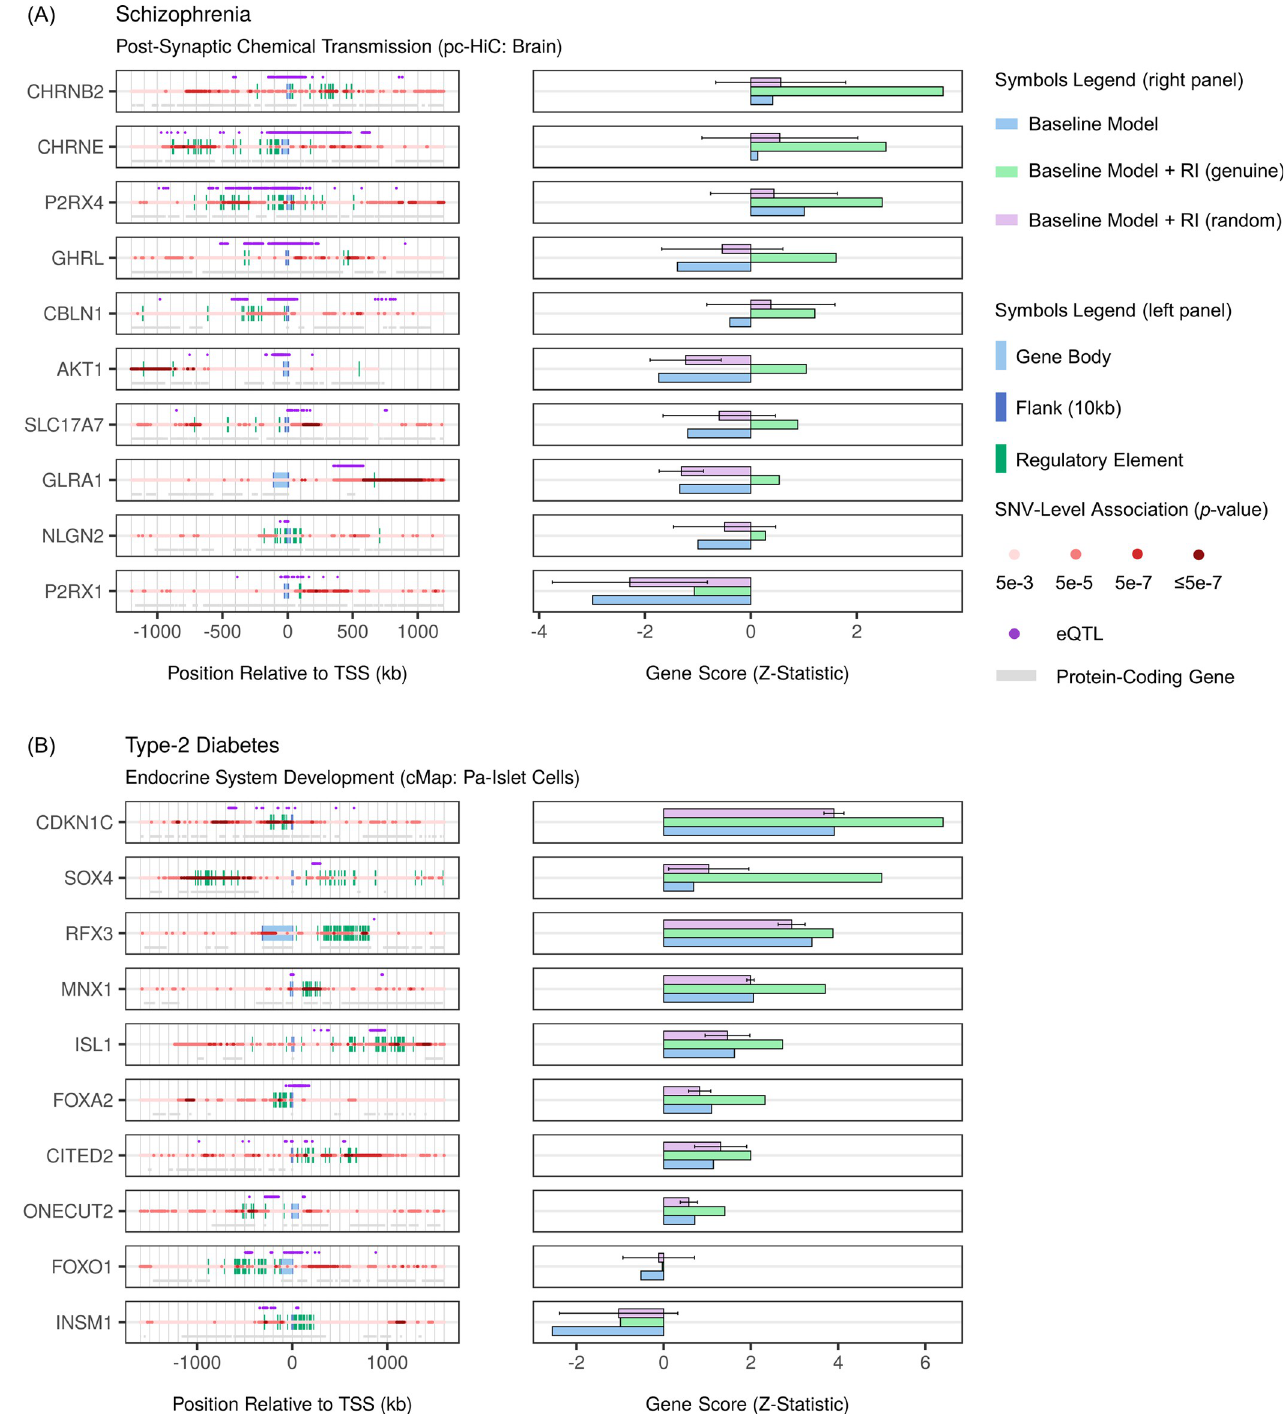
Fig 8. Identifying genes and regulatory elements that carry gains from particular augmentations for selected gene sets. (A) Ten top-gaining genes from the schizophrenia-associated gene set, post-synaptic chemical transmission (officially, go_chemical_synaptic_transmission_postsynaptic ), which gained from augmentation of the baseline model with the pc-HiC of brain dataset of regulatory interactions, were inspected to relate regulatory elements to schizophrenia risk. Left panel: illustrating genes in their genomic context to relate their regulatory elements to their gains (right panel), and in turn, to the gain at the level of the gene set itself. Regulatory elements that overlap with strong SNV-level associations for a phenotype (note, SNV-level associations from the GWAS dataset are depicted on the red midline) are of particular interest (note that the legend specifies the most significant SNV-level association represented by a given shade